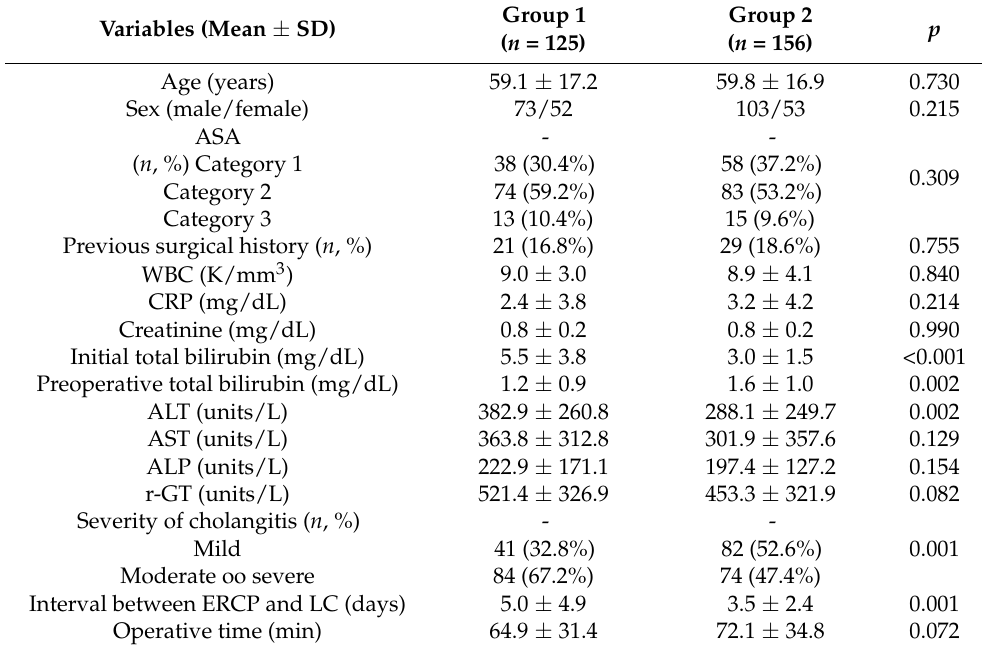
Table 1. Initial baseline characteristics of the enrolled